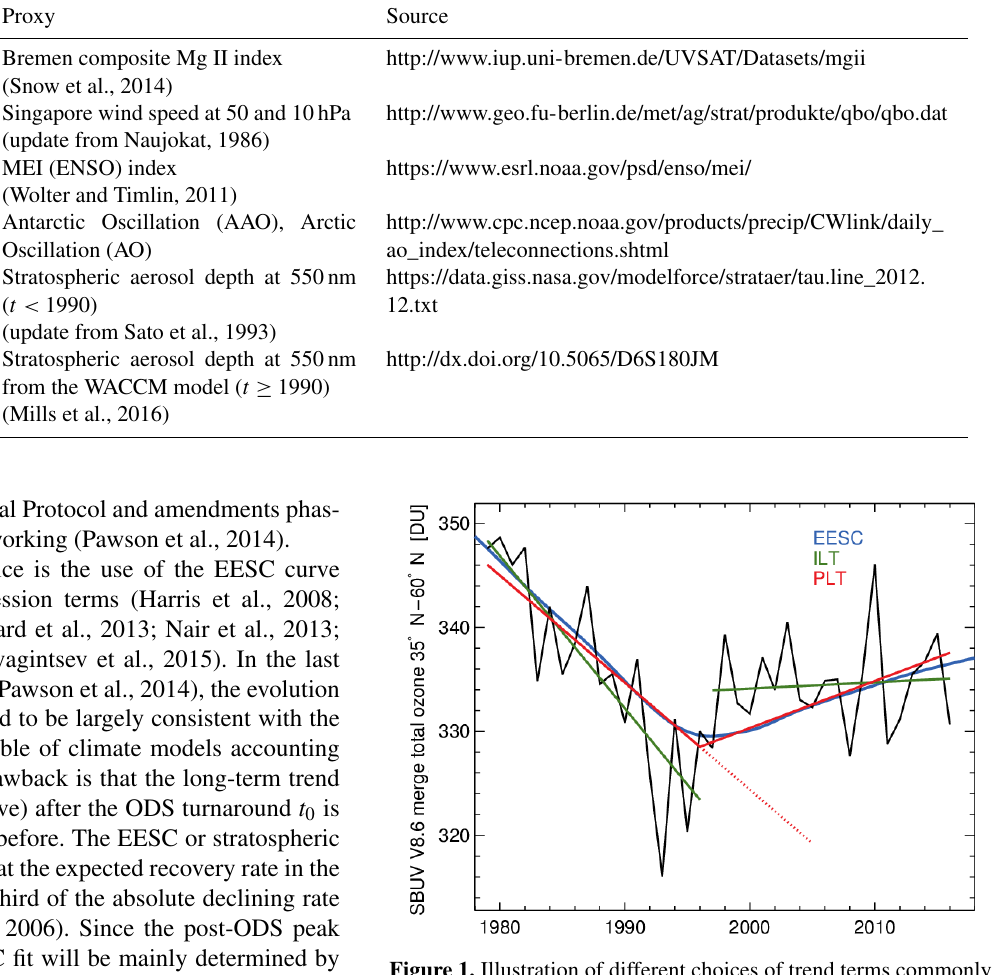
Figure 1. Illustration of different choices of trend terms commonly used in MLR applied to total ozone. Blue: EESC; red: PLTs before and after t 0 = 1996, also called hockey stick; green: ILTs. The black curve shows the NH total ozone time series from NOAA SBUV v8.6. The red dotted line indicates that the PLT is mathematically equivalent to using a trend change term in the MLR. The injection point is the point where the trend change terms starts (here, in the year 1996). All fits were done using only the linear regression terms in Eq. (1) or, alternatively, the EESC curve replacing linear regres- sion terms; see discussion in main